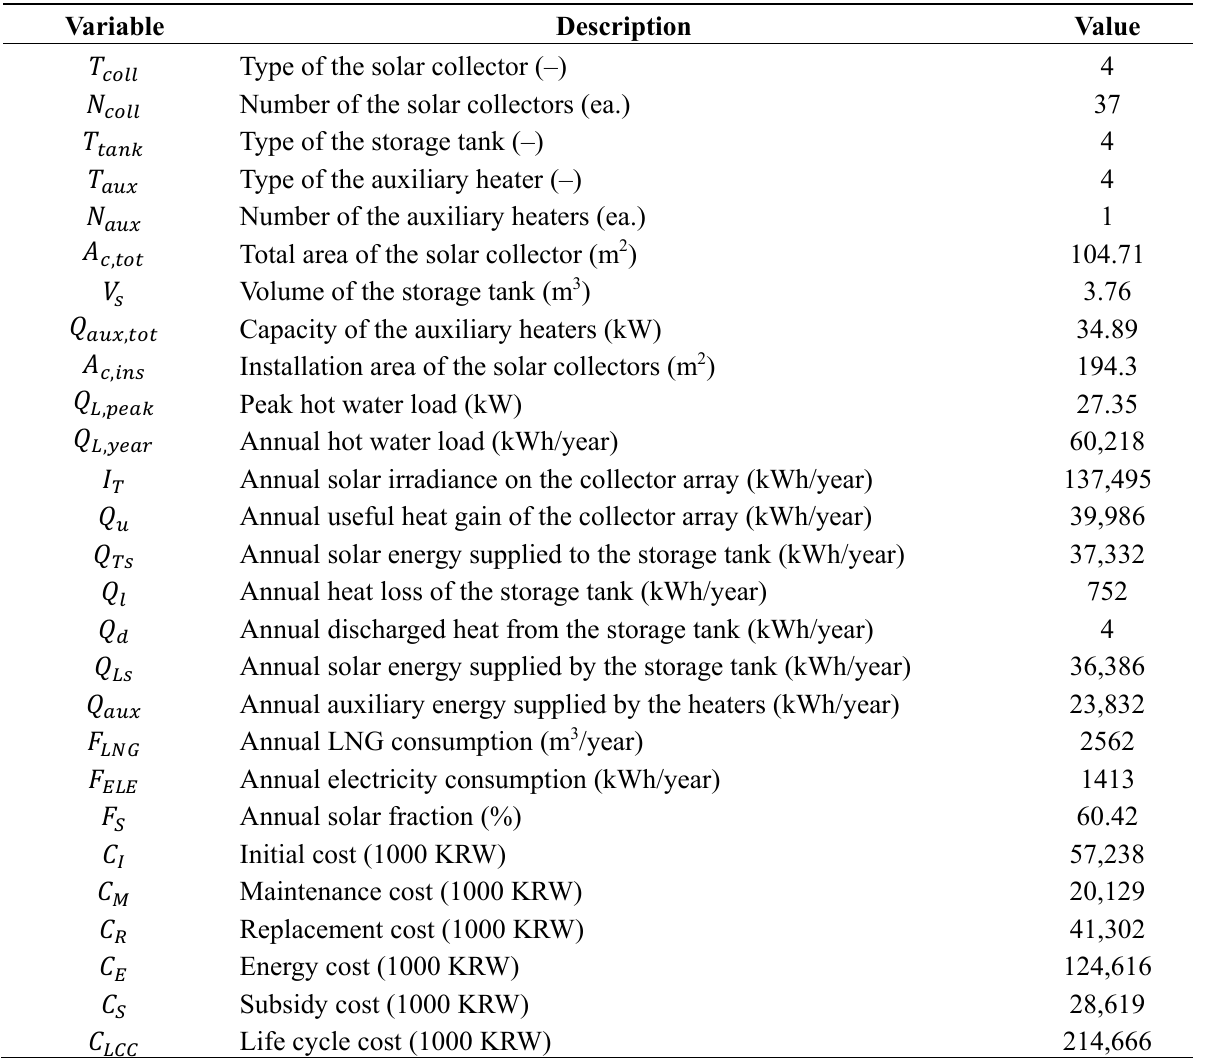
Figure 5. Variation of component size for the best and worst solutions in each generation for the base case. Table 6. Characteristics of the optimal SWH system for the base